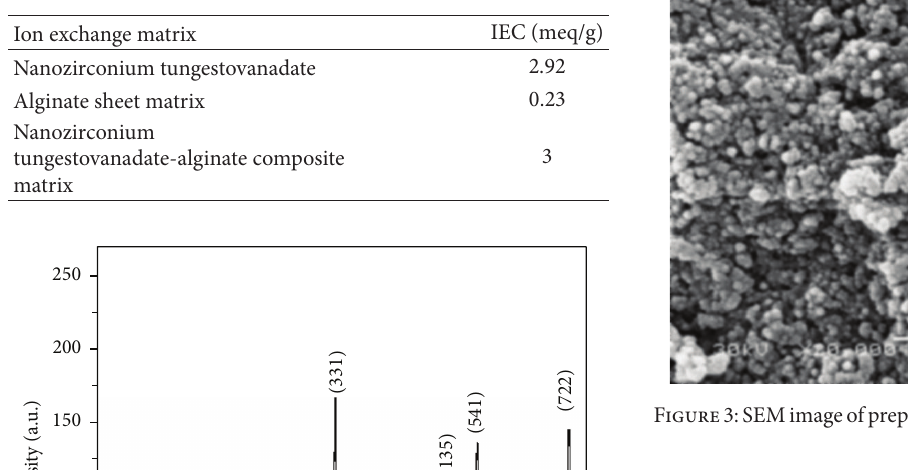
Table 1: Ion exchange capacity of prepared materials.